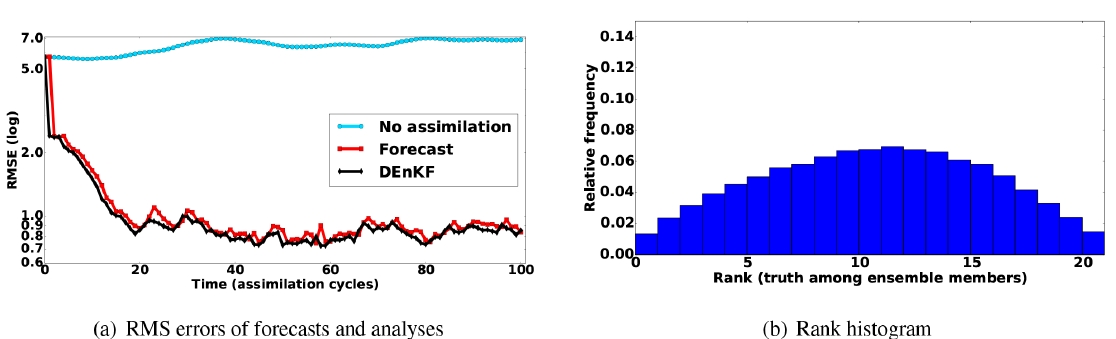
Figure 13. Data assimilation results. In panel (a) , “no assimilation” refers to the RMSE of the initial forecast (the average of the initial forecast ensemble) propagated forward in time over the 100 cycles without assimilating observations into it. The rank histogram of where the truth ranks among analysis ensemble members is shown in panel (b) . The ranks are evaluated for every 13th variable in the state vector (past the correlation bound) after 100 assimilation